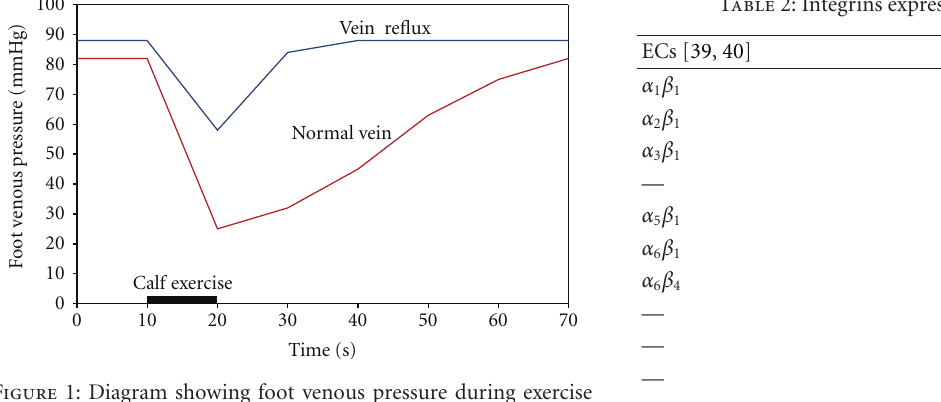
Figure 1: Diagram showing foot venous pressure during exercise in the standing position. Lower curve illustrates normal venous pressure while upper curve shows venous pressure in patients with venous reflux.